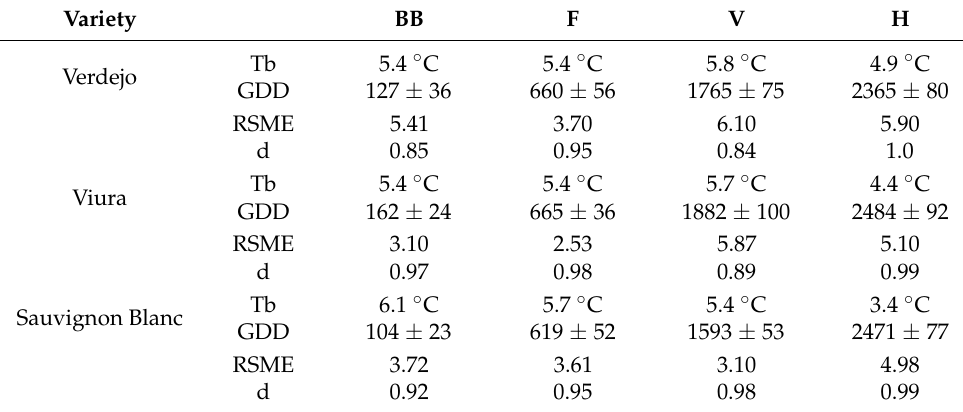
Table 3. Base temperature (Tb) and GDD accumulated from DOY = 80 (20 March) to reach budbreak, flowering, v é raison and ripening for each variety. RMSE (root square mean error) and d (Willcott index) of the fit between observed and estimated dates obtained in the validation processes.